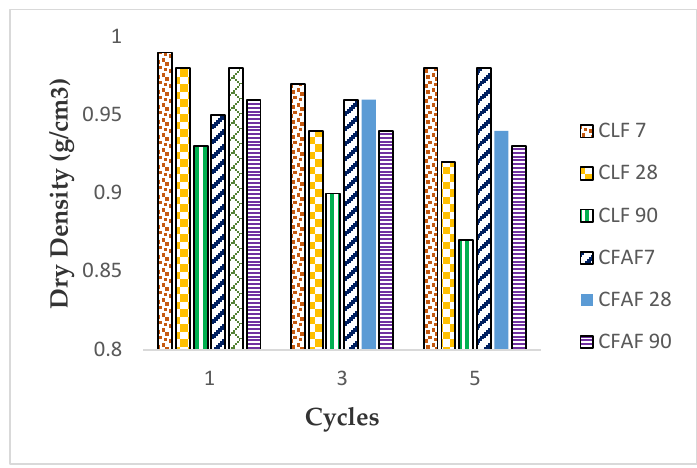
Figure 6. Dry density versus wetting/drying cycles.